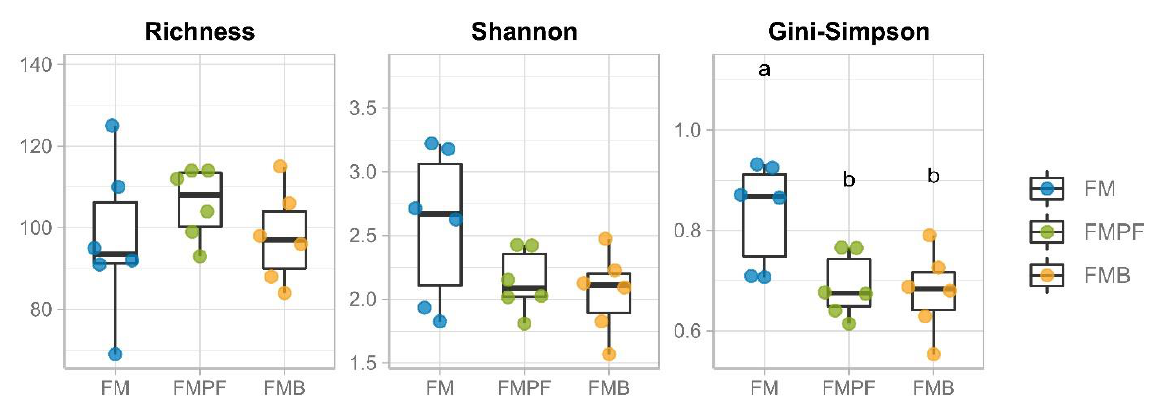
Figure 3. Richness and alpha-diversity (Shannon and Gini–Simpson). Comparisons of milk averages were made. Distinct letters indicate significant differences between